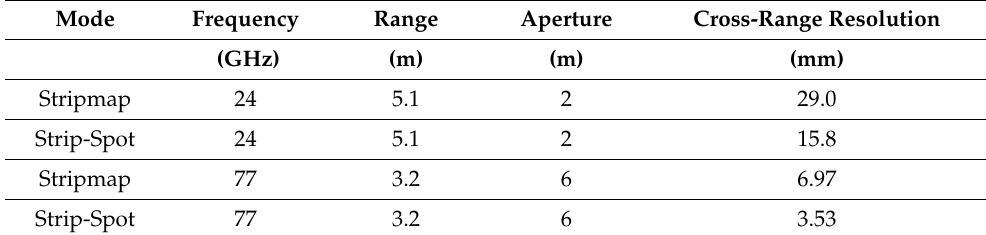
Table 2. The comparison of experimental